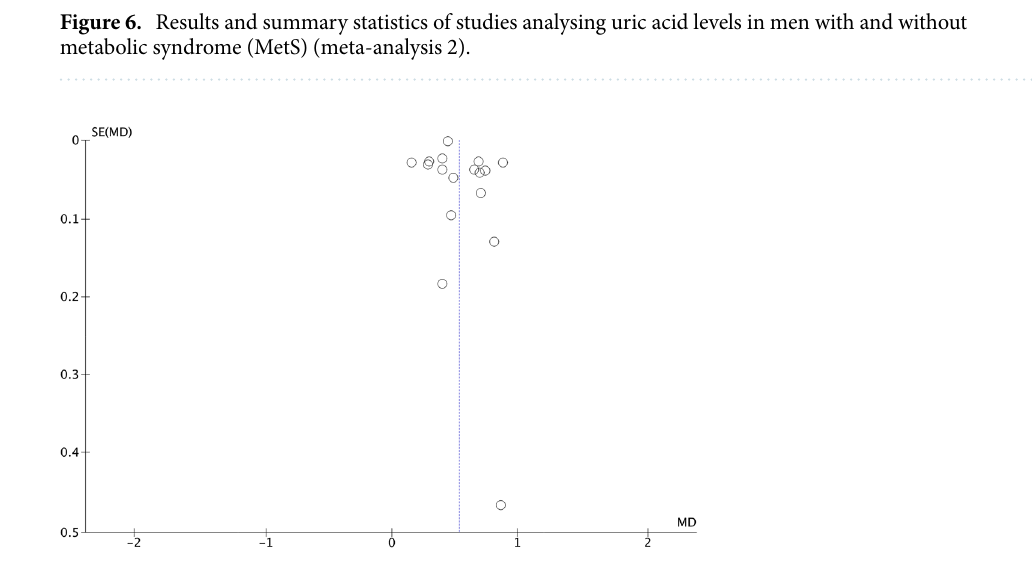
Figure 7. Funnet plot (meta-analysis